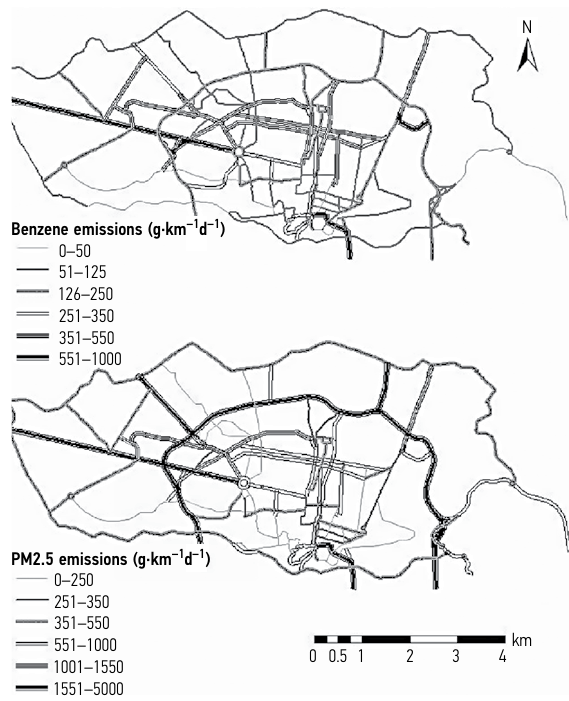
Fig. 8. Spatial distribution of benzene and PM2.5 daily emissions (average) in the modelling